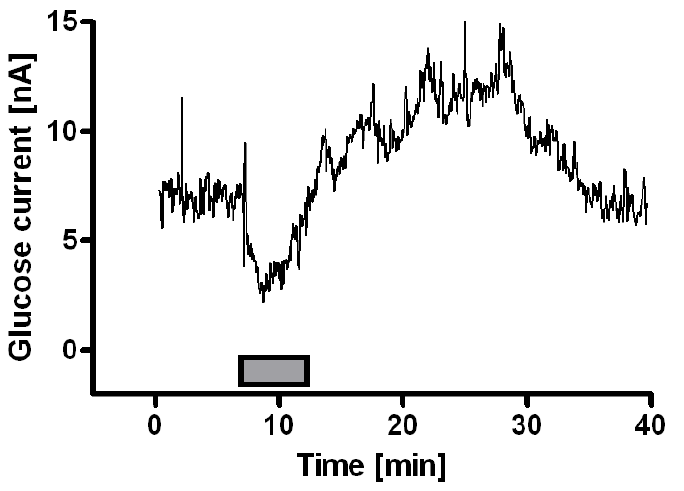
Figure 3. Effect of physiological stimulation on striatal glucose current. A 5-min tail